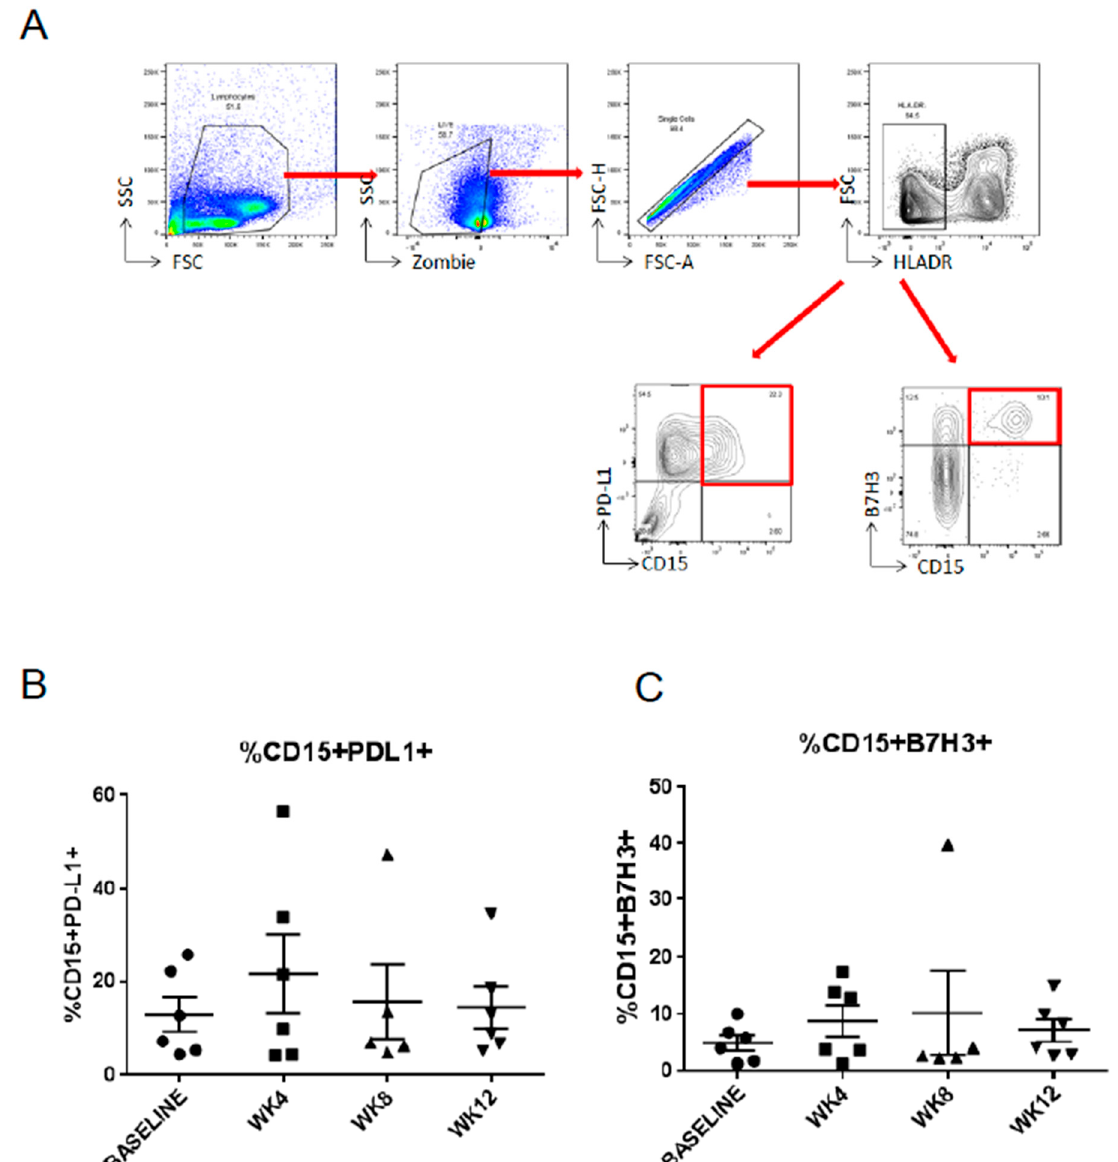
Figure 2. The expression of programmed death-ligand 1 (PD-L1) and B7-H3 on polymorphonuclear myeloid-derived suppressor cells (PMN-MDSCs) derived from prostate cancer patients. ( A ) Gating strategy to assess the expression of PD-L1 and B7-H3 on HLA-DR − CD15 + MDSCs in peripheral blood mononuclear cell (PBMC) using flow cytometry. Shown are flow cytometry dot plots with red arrows indicating the gating strategies and red rectangles the population of interest. ( B ) The surface expression of PD-L1 and ( C ) B7-H3 on the HLA-DR − CD15 + MDSCs as measured during the course of abiraterone and / or enzalutamide treatment ( n = 6 patients). WK: Week; SSC: Side Scatter; FSC: Forward scatter; HLADR: Human Leukocyte Antigen—DR isotype.